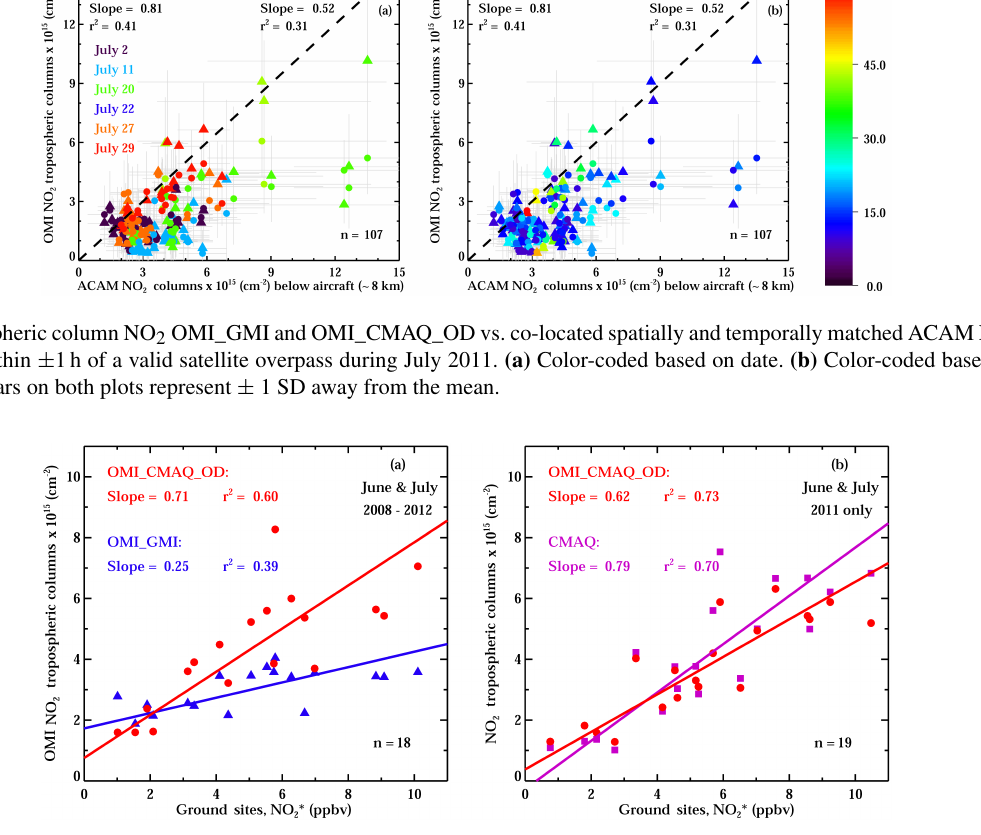
Figure 9. (a) Tropospheric column NO 2 OMI_GMI and OMI_CMAQ_OD vs. co-located ground NO 2 ∗ chemiluminescence measurements within ± 2h of a valid satellite overpass during June and July 2008 through 2012; all ∼ 300 daily ground monitor values are merged into a mean single value and compared to the satellite mean over the same corresponding time period. (b) Same as (a) but now comparing CMAQ and OMI_CMAQ_OD for June and July 2011